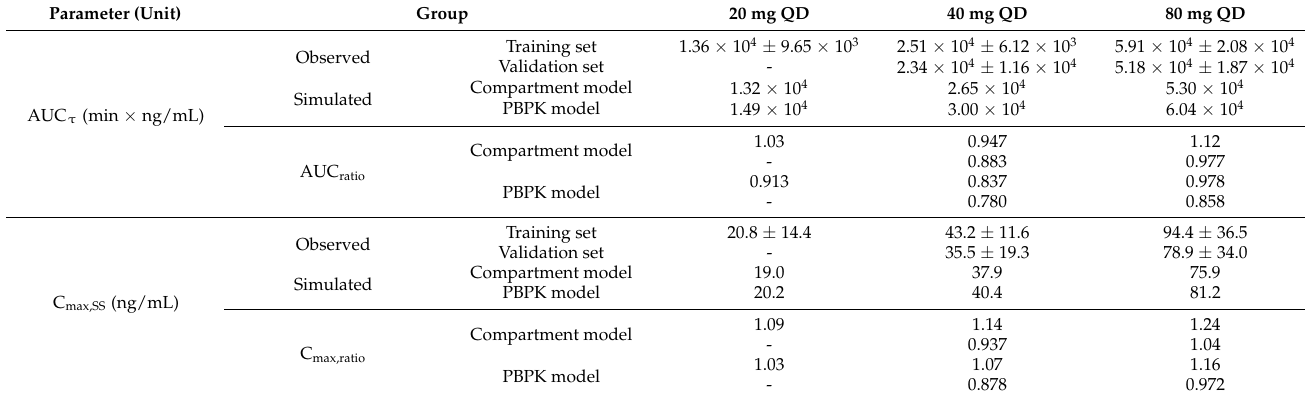
Figure 2. Pharmacokinetic profiles of fexuprazan in the training set for the one-compartment model. Observed data and simulated lines are plotted as markers and lines after 20 ( A ), 40 ( B ), and 80 mg/day ( C ) dosing. Closed circles ( • ) represent the mean and standard deviation of observed fexuprazan concentrations in plasma after PO administration. Black lines represent simulated plasma fex- uprazan concentrations using the PBPK model, and gray lines are fitted concentrations using the one-compartment model. Table 2. Estimated kinetic parameters for orally administered fexuprazan in humans. Simulated AUC τ and C max,SS were in a two-fold range of observed values for the training and validation